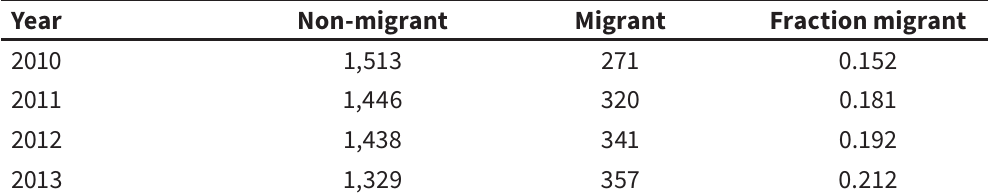
Migrant and non-migrant households Year